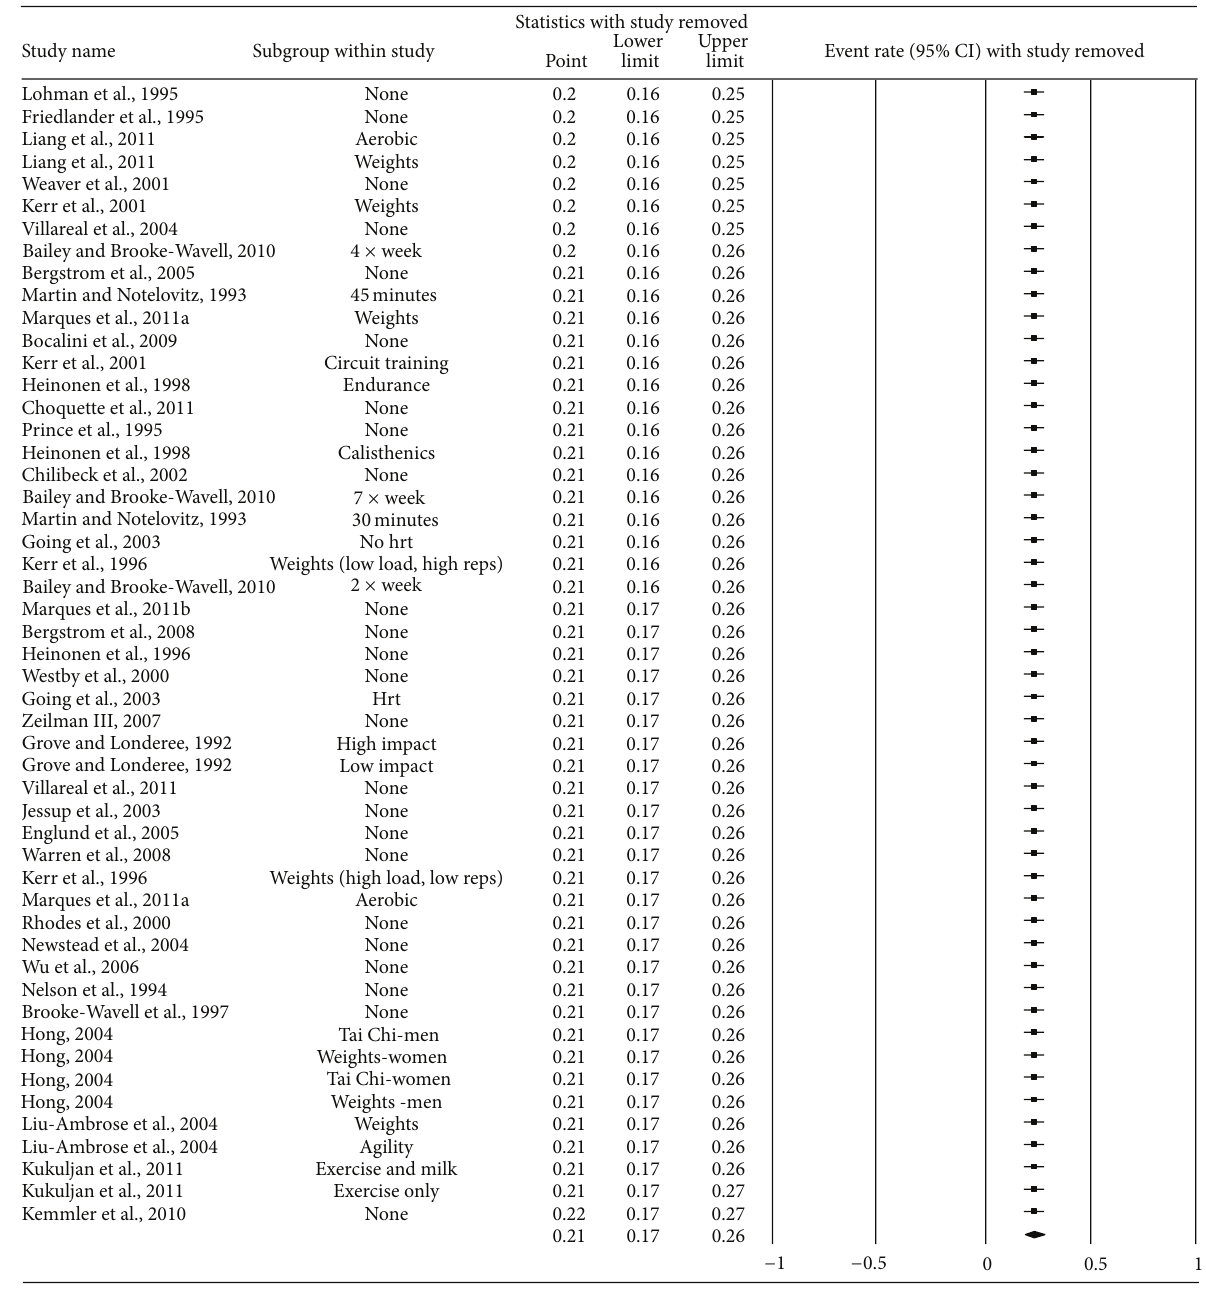
Figure 3: Influence analysis for exercise dropouts. Influence analysis for exercise group dropouts with each group deleted from the model once. The black squares represent the event rate while the left and right extremes of the squares represent the corresponding 95% confidence intervals. The middle of the black diamond represents the overall event rate while the left and right extremes of the diamond represent the corresponding 95% confidence intervals. Results are ordered from the smallest to the largest values